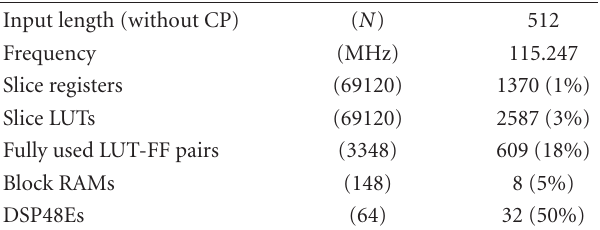
Table 2: Synthesis results of the